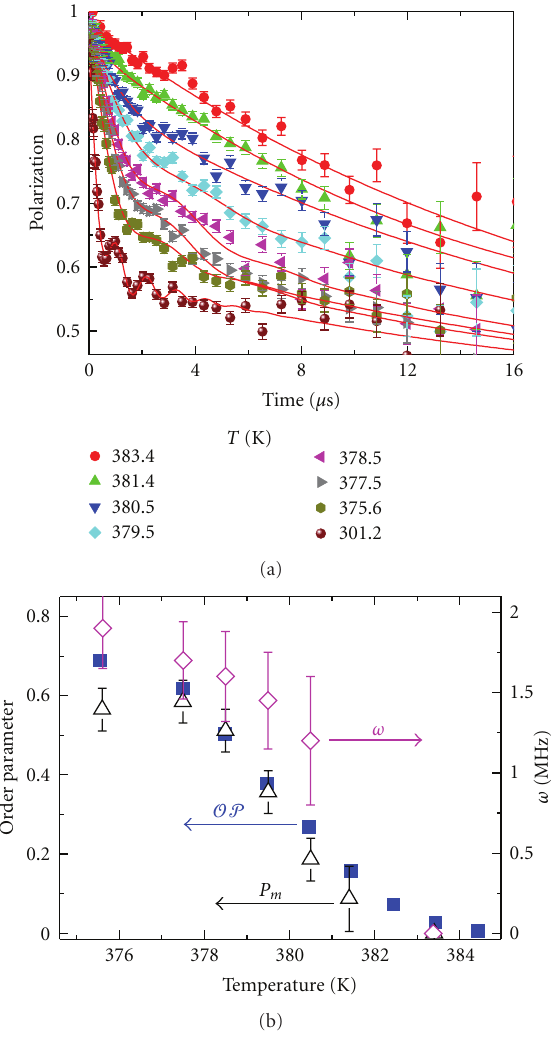
Figure 3: (a) The μ SR raw data at di ff erent temperatures and fits of (3) to the data in solid lines. (b) Comparison between three di ff erent methods used to describe the AFM phase transition: (i) the muon precession frequency ω obtained from (3). (ii) the magnetic volume fraction P m determined by (3), and (iii) OP calculated by (4).